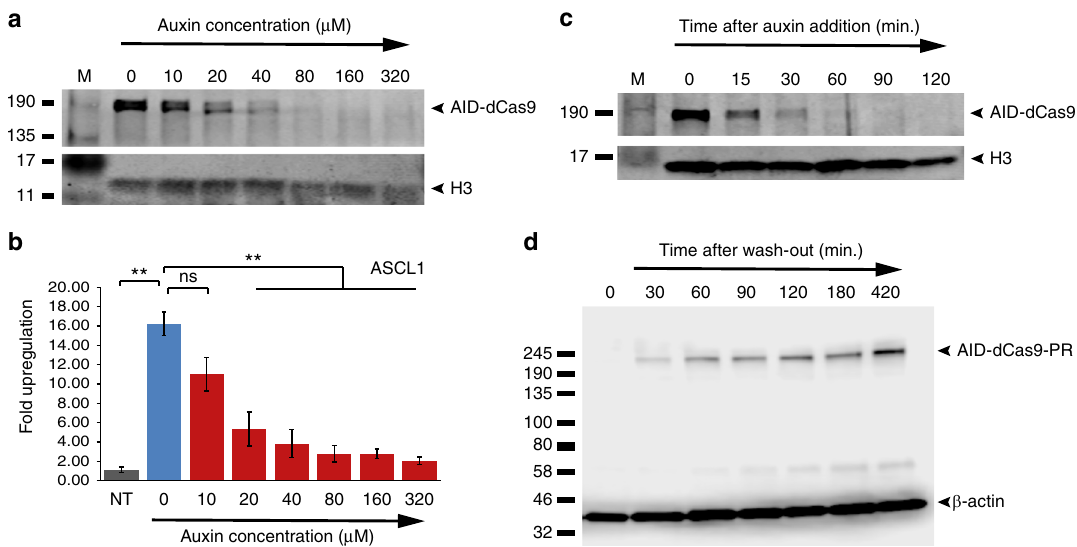
Fig. 3 Concentration dependence and kinetics of the AID-dCas9-effector system. a Western blot on protein extracts from AID-dCas9 expressing HEK293 cells probed with Cas9 and histone H3 (control) antibodies showing the degradation ef fi ciency of AID-dCas9 is dependent on the auxin concentration in the media. b Functional tunability of AID-dCas9 effectors. A stable AID-dCas9-PR cell line was transfected with a mix of guide RNAs targeting the ASCL1 promoter region. Auxin was added to the concentrations indicated. mRNA induction levels decreased with increasing auxin concentration. Black columns, NT, no sgRNA transfected; Blue columns, no auxin added; Red columns, auxin added at indicated concentration. Error bars denote ± s.d. ( n = 3), (two-tailed t -test, (**) P < 0.01, (*) P < 0.05, (ns) not signi fi cant). c Time course of the disappearance of AID-dCas9. Western blot of samples taken at the indicated time periods after addition of auxin. d Media wash-out and replacement with media without auxin results in detectable reappearance of AID-dCas9